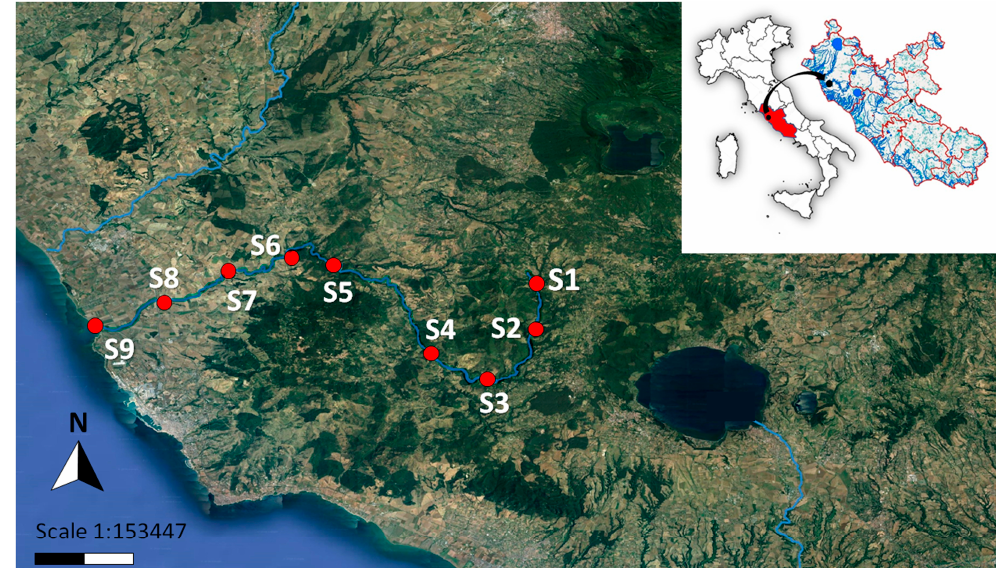
Figure 1. The sampling sites of water, sediments and macroinvertebrates along the River Mignone are highlighted from site 1 (S1), located near the source, to site 9 (S9), located near the mouth (image processed by QGIS ver. 3.12.2).